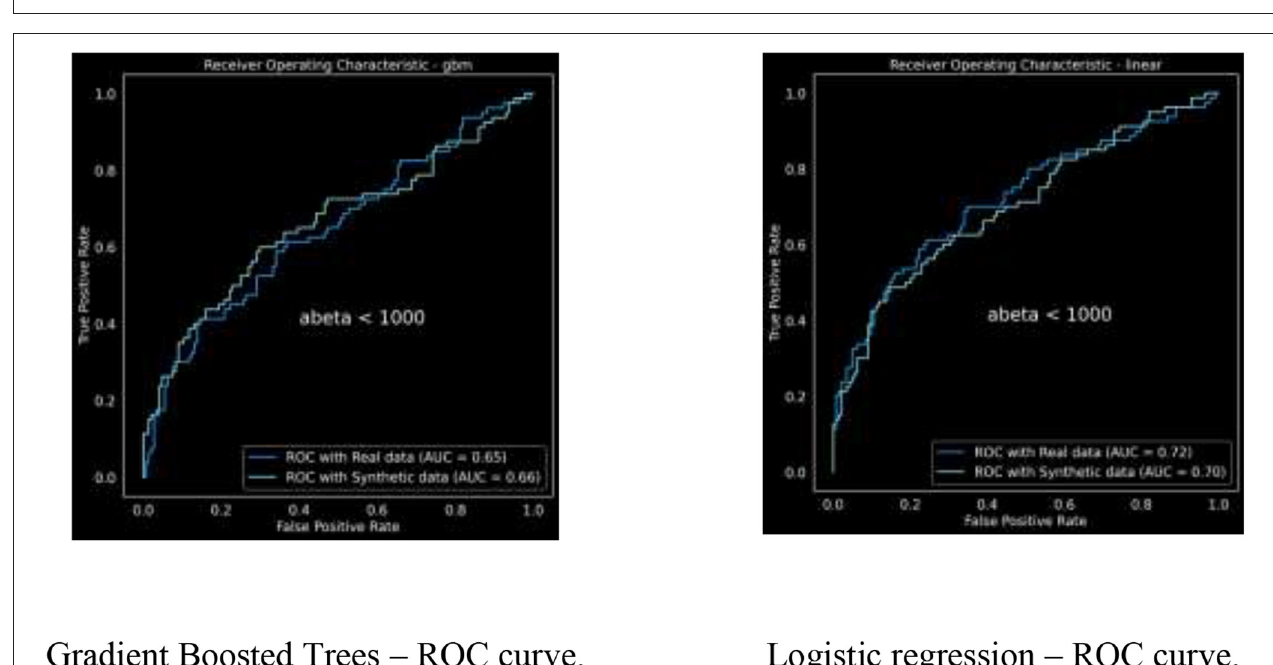
FIGURE 3 | Receiver operating curves for real vs. synthetic (single